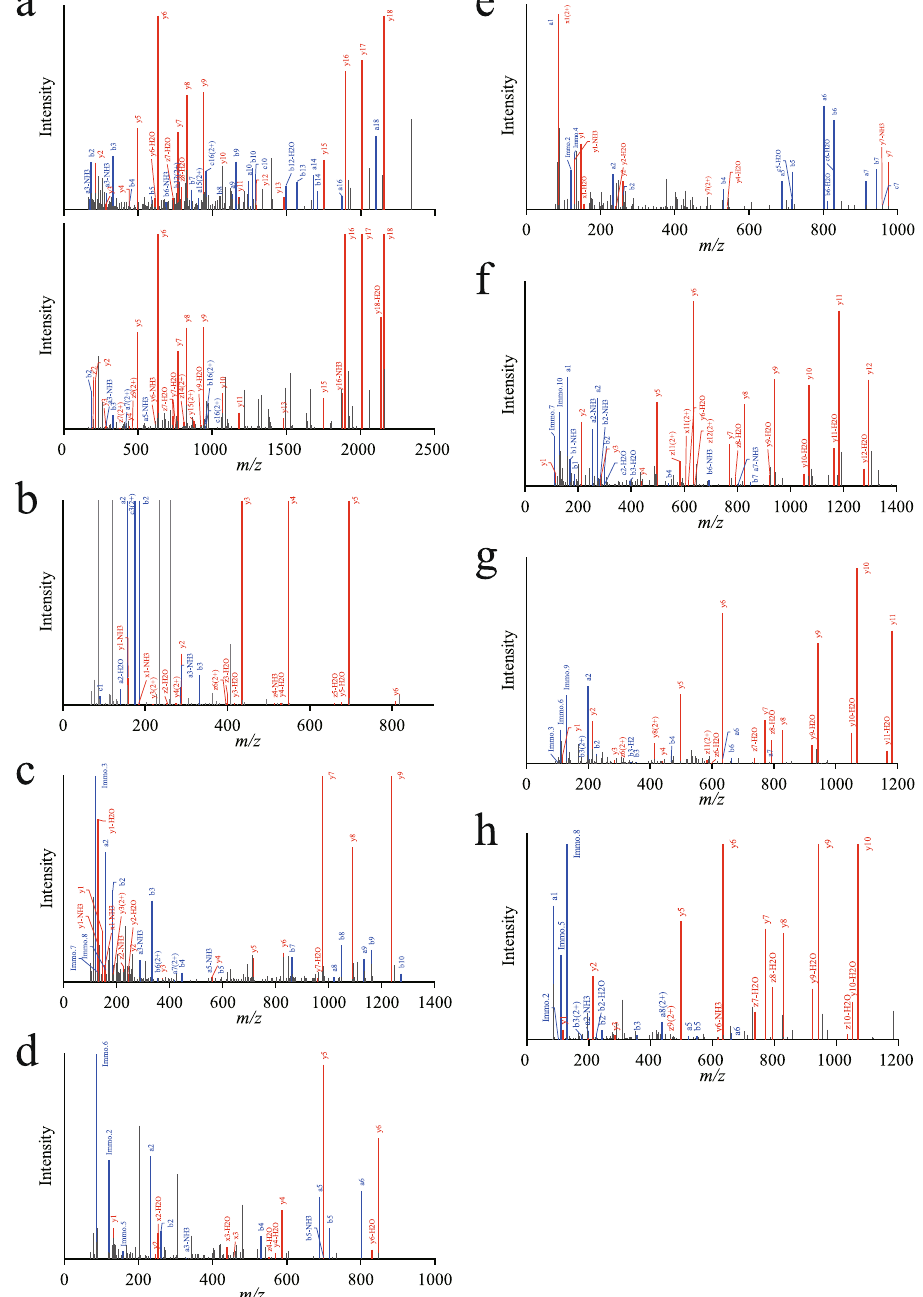
Figure 1. MS/MS spectra for salusin- β and its endogenously fragmented peptides directly identified from healthy human plasma. Human plasma extracted using the improved differential solubilization method was prefractionated and subjected to LC-MS/MS analysis. ( a ) MS/MS spectra with the sequence assignments of fragment ions correspond to salusin- β “AIFIFIRWLLKLGHHGRAPP” with a m/z of 586.35 (molecular mass of 2,341.37 Da). The MS/MS spectra of synthetic salusin- β (upper panel) was compared to the original spectrum observed in a plasma sample (lower panel) to confirm the putative identification. ( b–h ) MS/MS spectra corresponding to partial sequences of salusin- β directly identified using non-tryptic human plasma samples are presented: ( b ) salusin- β (1–7), ( c ) salusin- β (1–11), ( d ) salusin- β (4–10), ( e ) salusin- β (4–11), ( f ) salusin- β (8–20), ( g ) salusin- β (9–20), ( h ) salusin- β (10–20). MS/MS spectra were deconvoluted into singly charged ions from the observed spectra and peaks were assigned theoretical m/z values for fragment ions. The m/z differences between theoretical and observed values for most assigned peaks were less than 0.01 Da. The identified cleaved peptide sequences of salusin- β after PEAKS studio database searches are presented. The annotations of the identified matched amino terminus-containing ions are shown in blue and the carboxyl terminus-containing ions in